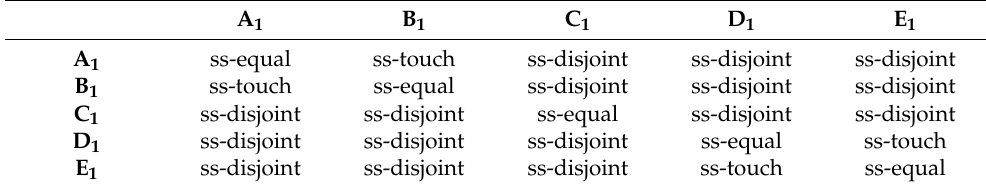
Figure 17. ( a ) Query scene. ( b – e ) Database scenes. Table 10. Topological relations in the query scene (a) in Figure 17.